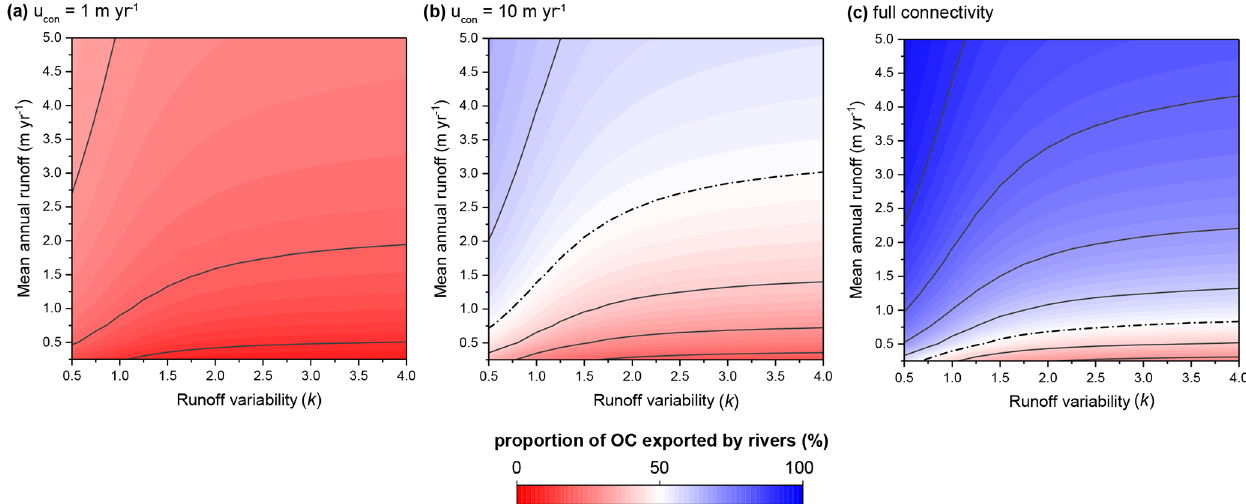
Figure 9. Proportion of landslide-mobilized OC that has been exported by rivers over one seismic cycle as a function of mean annual runoff and runoff variability. Three scenarios of landslide connection velocity are shown: (a) u con = 1myr − 1 , (b) u con = 10myr − 1 and (c) full connectivity. The lines represent contours of the proportion of OC exported by rivers and are incremented every 10%, but the dashed line represents the 50%